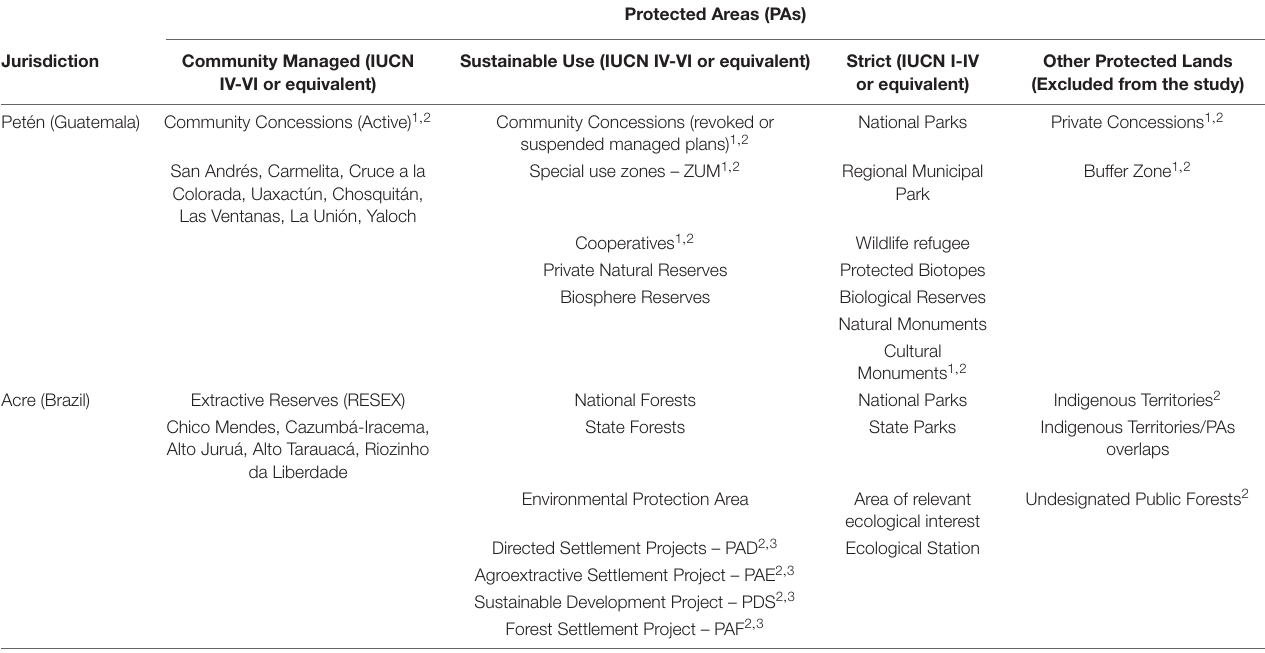
TABLE 1 | Protected Areas (PAs) categories included in the department of Petén (Guatemala) and the state of Acre